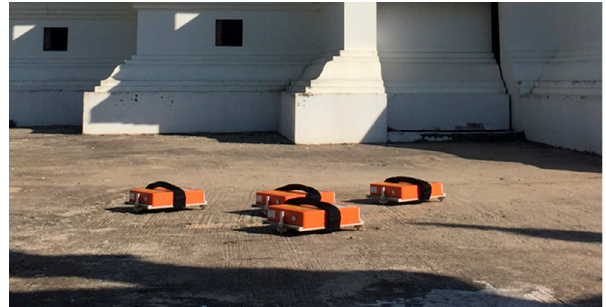
Figure 5. Sample of array observation station.